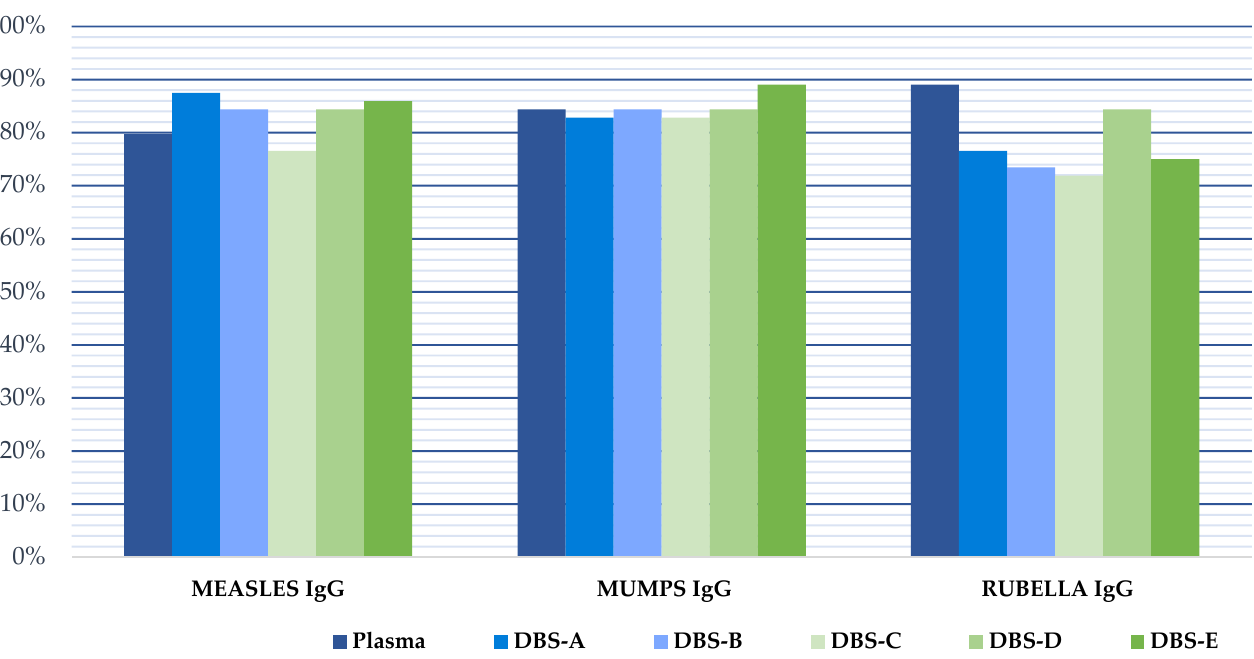
Figure 3. Pathogen immunity against measles, mumps and rubella in our study population considering the manufacturer cut-off for plasma and the optimized DBSs cut-off for all DBSs analysis. DBS-A: DBSs processed without delay and eluted with an adjusted volume of PBS, taking into account the hematocrit; DBS-B: DBSs without delay and eluted with 1 mL of PBS; DBS-C: DBSs stored at − 20 ◦ C for 4 months; DBS-D: DBSs stored at 4 ◦ C for 4 months; DBS-E: DBSs stored at room temperature for 4 months.